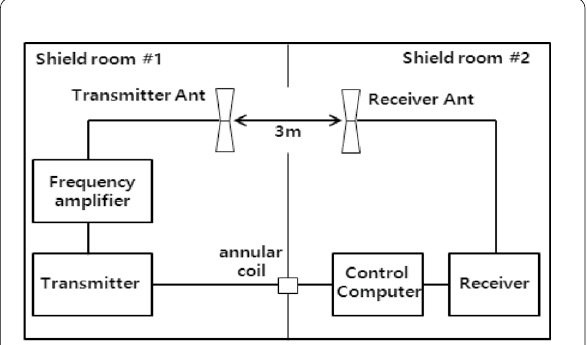
Fig. 6 Results of flow test.